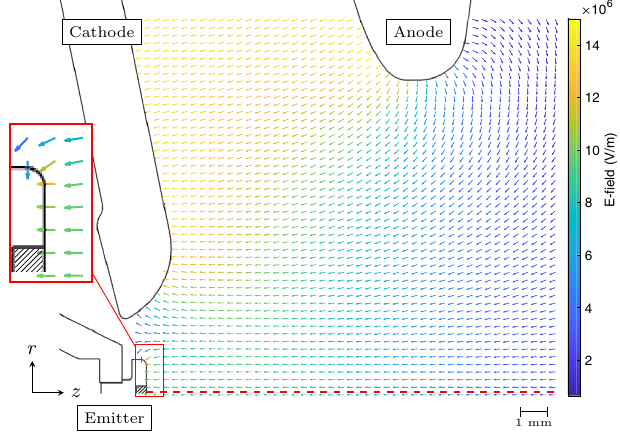
FIG. 3. Electric field map between the anode and cathode. The field is rotationally symmetric with respect to the dashed red line, while the hatched area depicts the LaB 6